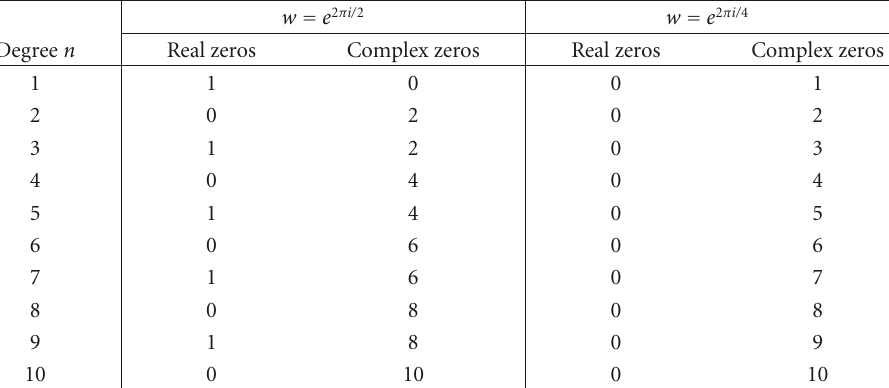
Table 4 . 1 . Numbers of real and complex zeros of E n , q , w ( x ).